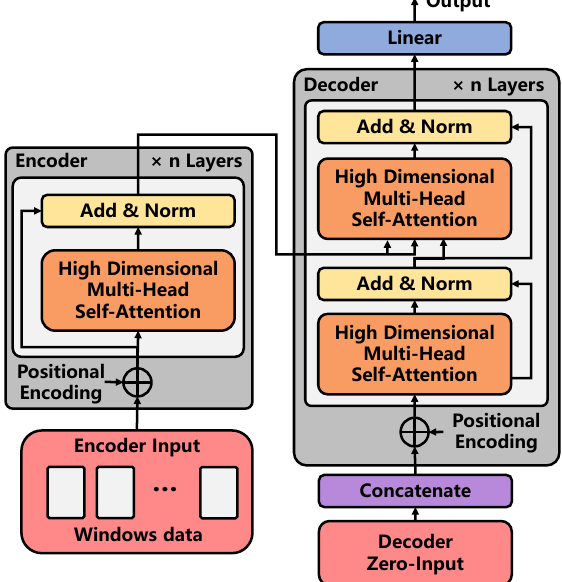
Figure 7. The process of temporal correlation